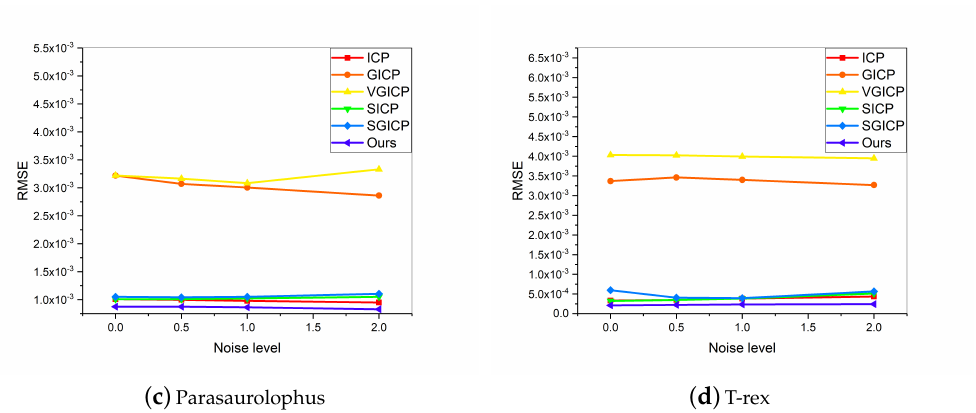
Figure 8. Average RMSE of several methods at different noise levels on the UAW dataset.